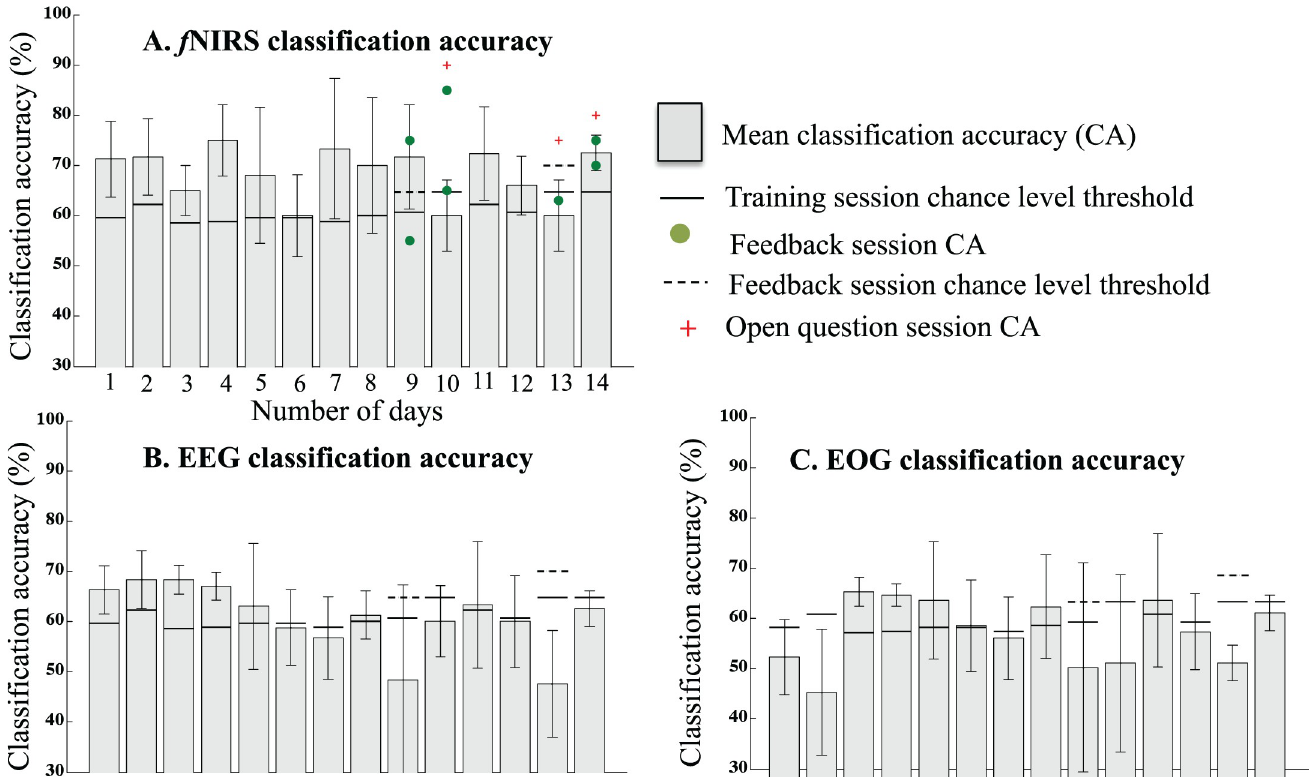
Fig 2. Classification accuracy of Patient F. Linear SVM CA across “training sessions—offline CA” (histogram in grey), “feedback sessions—online CA” (green dot), and “open question session—online CA” (plus sign in red), obtained using (A) relative change in O2Hb, (B) EEG, and (C) EOG data. The classification accuracy reported here is daywise, as all the “training sessions” in a day were used to calculate the average classification accuracy of all the “training sessions” in a day. In the figure panels A, B, and C, the x-axis is the number of days and the y-axis is the classification accuracy. The solid black and dotted horizontal lines represent the chance-level threshold calculated using the metric described in the BCI effectiveness metric section for “training sessions” and “feedback sessions,” respectively. Since the feedback during the feedback and open question sessions was provided using the O2Hb, the online CA of the feedback and open question sessions is reported only for the fNIRS data. Fig 2 data is located at https://doi.org/10.5281/zenodo.1419151;